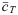
Structure of the nullclines at different values of c¯T indicated in the title of each panel.The black line indicates the nullcline c˙d=0, while the orange line corresponds to c˙sr=0. The red curve is a trajectory with a direction indicated by the red arrows.